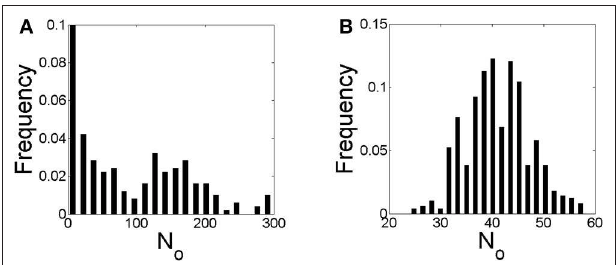
FIGURE 6 | Distribution of the number of IP 3 Rs, N o , that participate of a global Ca 2 + release event derived from stochastic simulations of the model described in section 2.4 but with a mean separation between clusters of 4 µ m and δ Ca 200 s − 1 (A) and δ Ca 20 s − 1 (B) , i.e., conditions S1 and S2 of = = Table 3 , respectively.